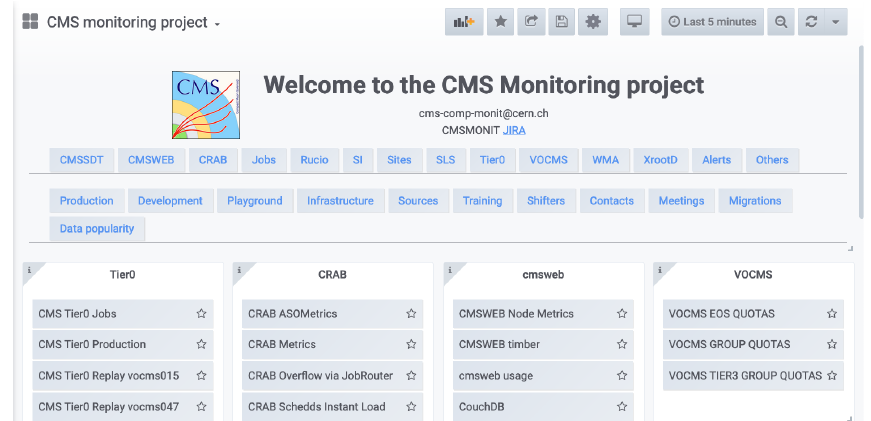
Figure 2. Screenshot of the CMS monitoring portal based on